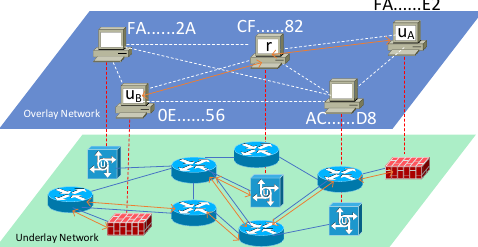
Figure 13. Packet flow diagram of unreachable nodes u A and u B in the overlay and underlay planes establishing connections via reachable node r relays.